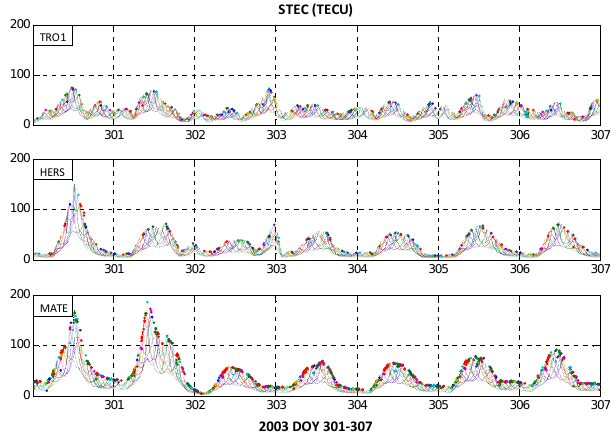
Fig. 9. Ion2 (m) for GPS L1 (Ion2L1) for the observation stations on DOY 301‐307 in 2003.